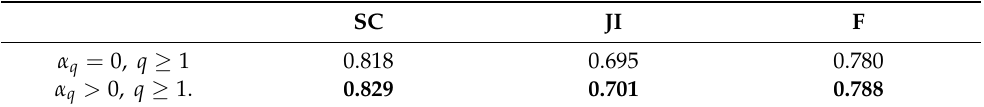
Figure 5. Effectiveness of BDPM to the segmentation results. ( a – d ) are images from [49,50]. First row: α q = 0, q ≥ 1. Second row: α q > 0, q ≥ 1. Table 4. Quantitative comparisons for the effectiveness of BDPM to the segmentation performance for WSE database. The best results are highlighted in bold.